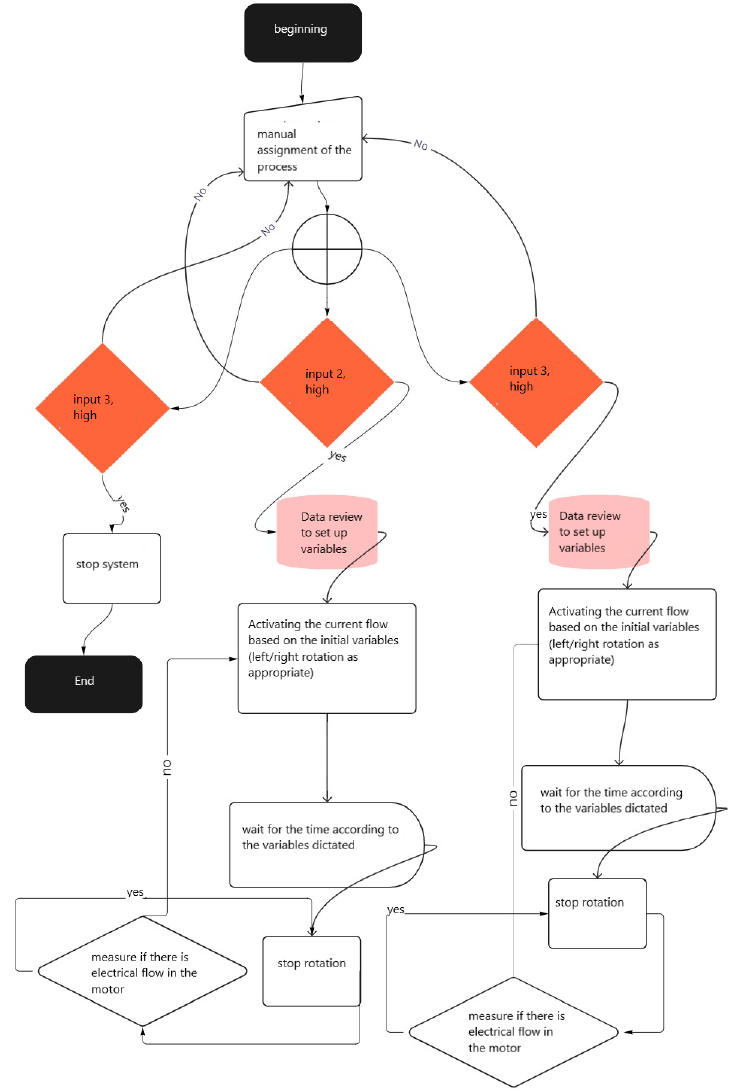
Figure 15. Flowchart of the software for controlling the time and rotation of the Automatic Equipment to increase sustainability in agricultural fertilization.